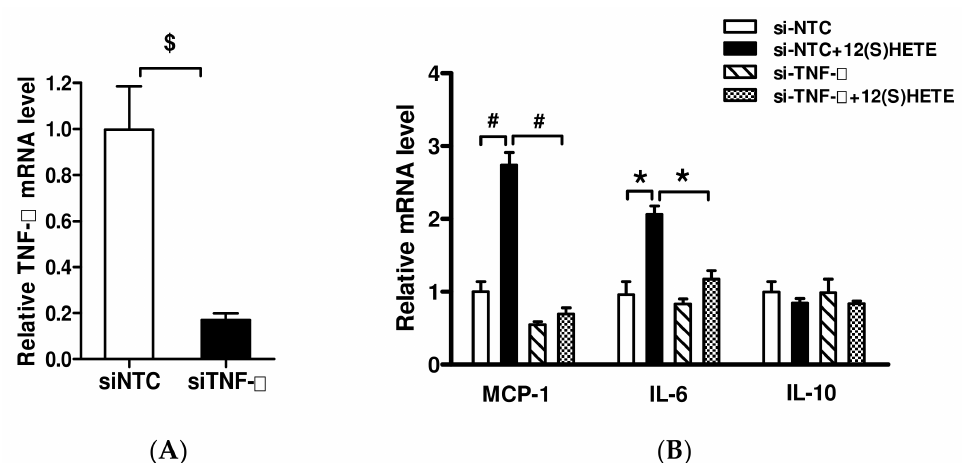
Figure 4. Inhibition of TNF- α expression on 12(S)HETE-activated inflammatory factor expres- sion. ( A ) MOs were transfected with siRNAs targeting TNF- α (si-TNF- α ) or non target control (si-NTC) oligonucleotides, and gene expressions were detected by RT-qPCR assays. Data represent mean ± SEM, n = 3. $ p < 0.001 versus siNTC. ( B ) Transfected MOs were SD for 24 h, then treated with 12(S)HETE for 8 h and expression of indicated genes was determined by RT-qPCR. Results are shown as fold over siNTC (mean ± SEM, n = 3. * p < 0.05, # p < 0.01 vs. siNTC or siTNF- α